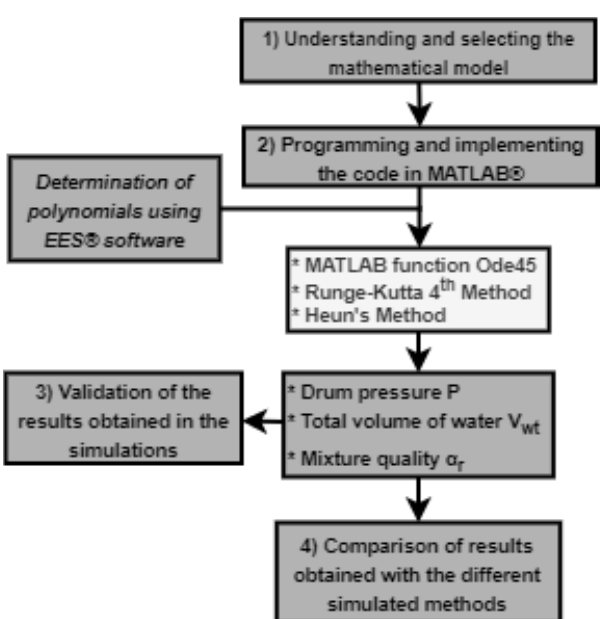
Figure 1. Block diagram representing the research development process.